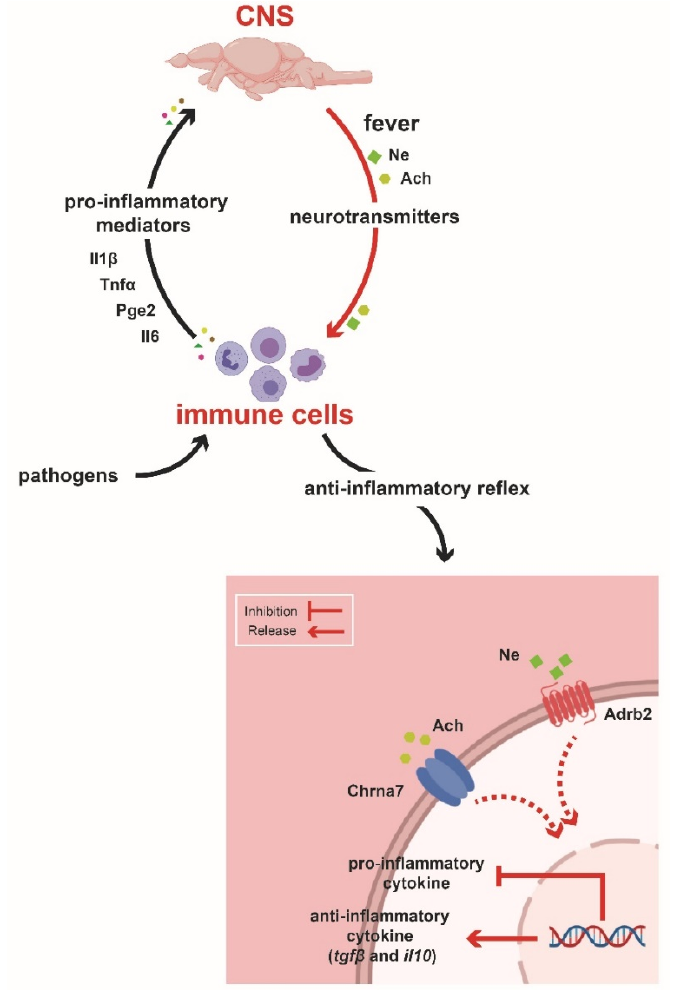
Figure 9. Working model of the Immune–Sensory–Neuron Interface during behavioural fever .